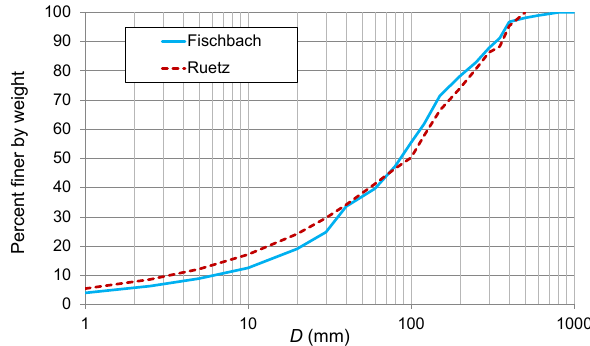
Figure 4. Grain size distribution (GSD) of the surface bed mate- rial upstream of the measuring sites. The GSD was measured on 3 October 2012 at the Fischbach and on 4 October 2012 at the Ruetz. The line-by-number samples included observations for grain sizes D > 10mm, and they were averaged and transformed into a volumetric sample by assuming a 12% unmeasured proportion of D < 10mm (Recking, 2013) and combining it with a Fuller-type distribution for the fine material (Fehr,